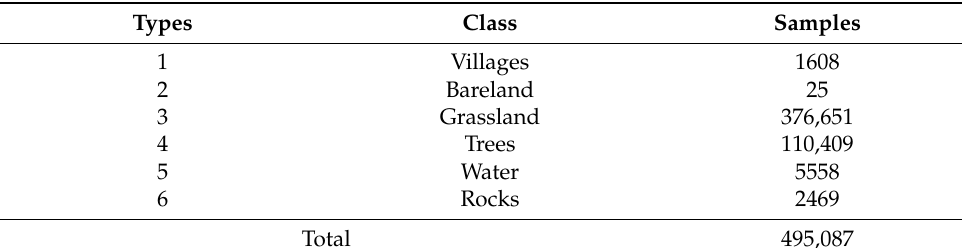
Table 5. The number of samples and six